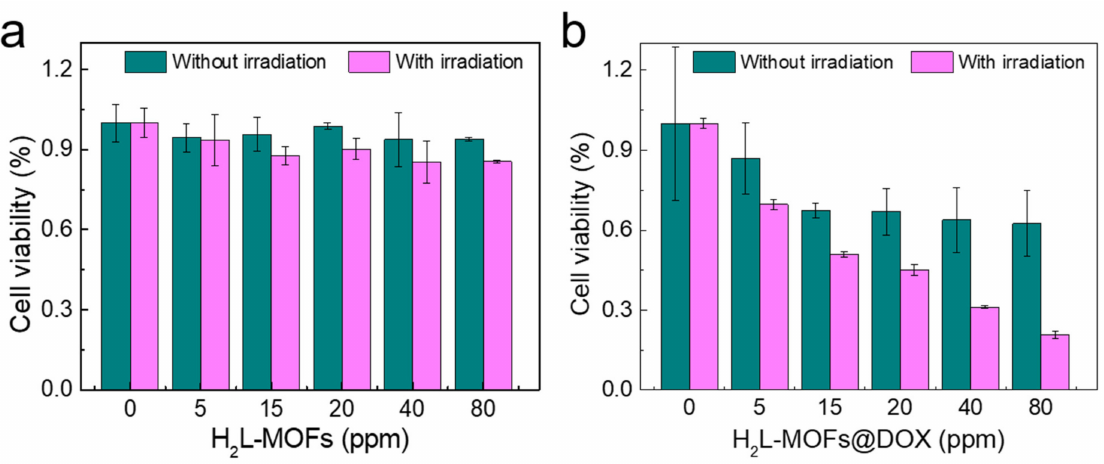
Figure 5. Cell viability of ( a ) H 2 L-MOFs and ( b ) H 2